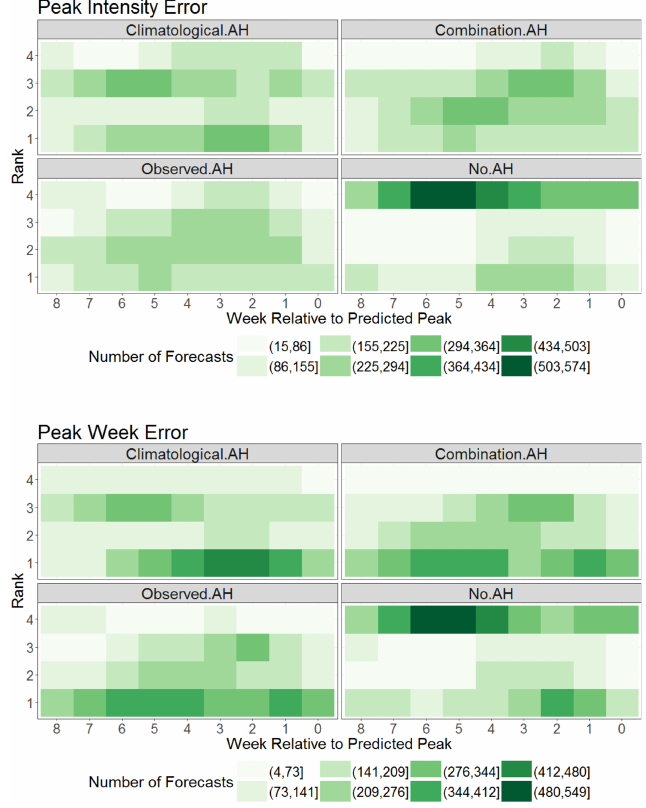
Fig 2. Heat map of forecasterror rank for predictions of peak intensity (top) and peak timing (bottom) plotted as a function of forecast lead relative to the predicted peak. Weekly forecasts for a location were ranked(1–4) basedon predictionerror for a given metric, where 1 was the forecast with the least error. Color indicatesthe numberof forecasts at each lead with a given error rankingrelative to the other forms. Darker colors indicate more forecasts at a given leadwith a particular ranking.